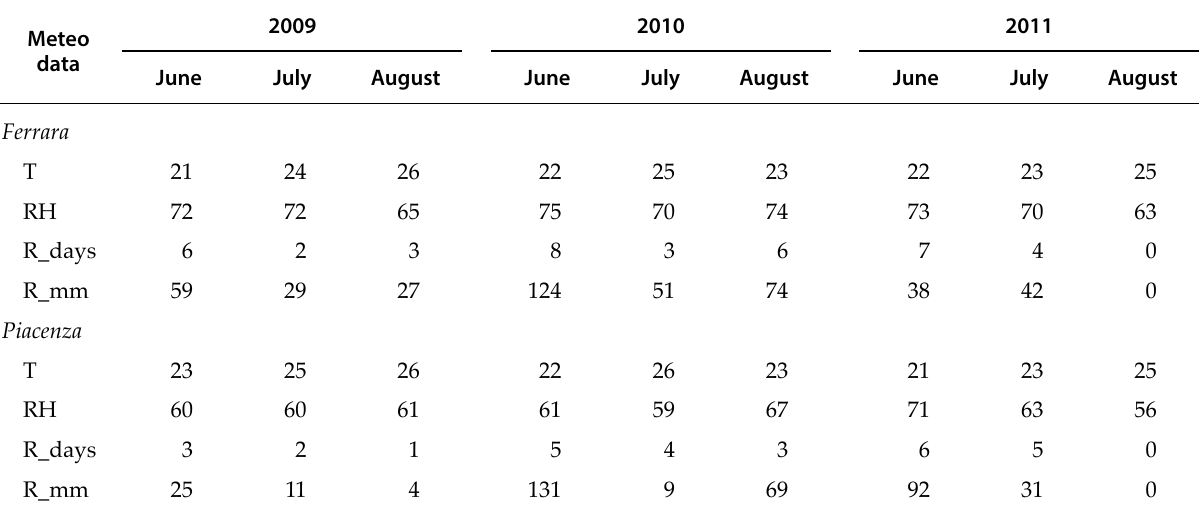
Table 1. Mean monthly temperature (T, °C), mean monthly relative humidity (RH, %), mean monthly summation of rainfall (R_mm,) and days with rain (R_days) in June, July and August of 2009, 2010 and 2011 measured at two meteorological stations located in the provinces of Piacenza and Ferrara, Northern